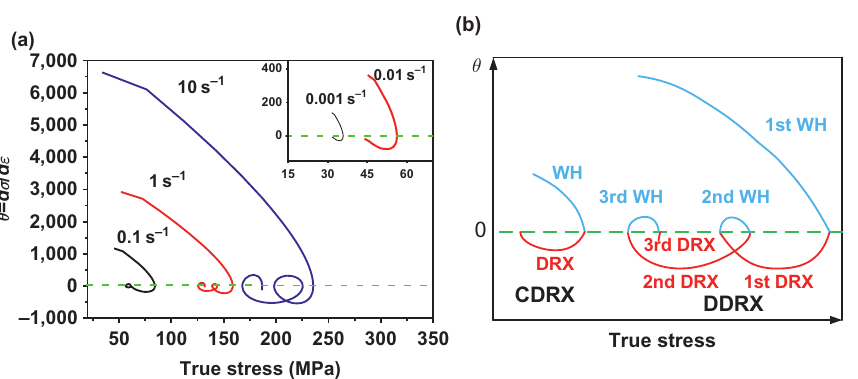
Figure 6: (a) Hardening rate of the specimens at the temperature of 1,030°C and (b) schematic of the hardening rate curves of the two types of DRX.